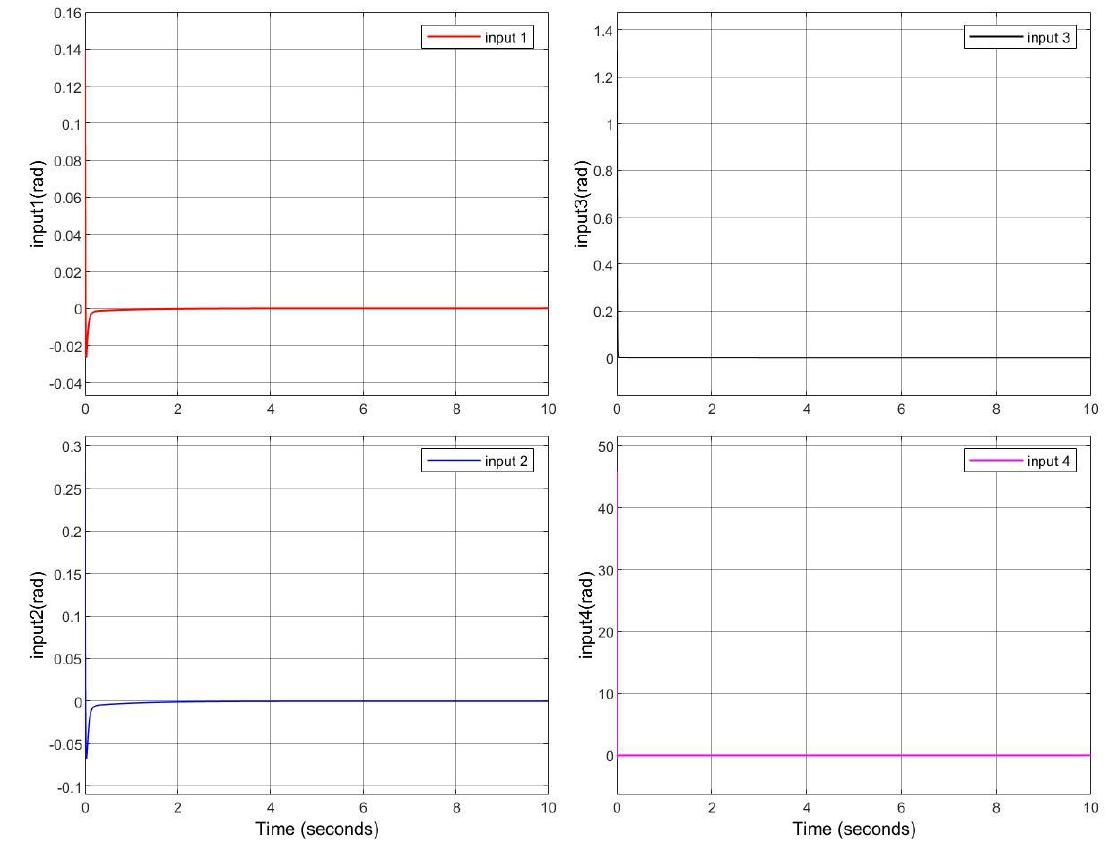
Figure 3. Simulation of inputs 1 – 4 without actuator faults.